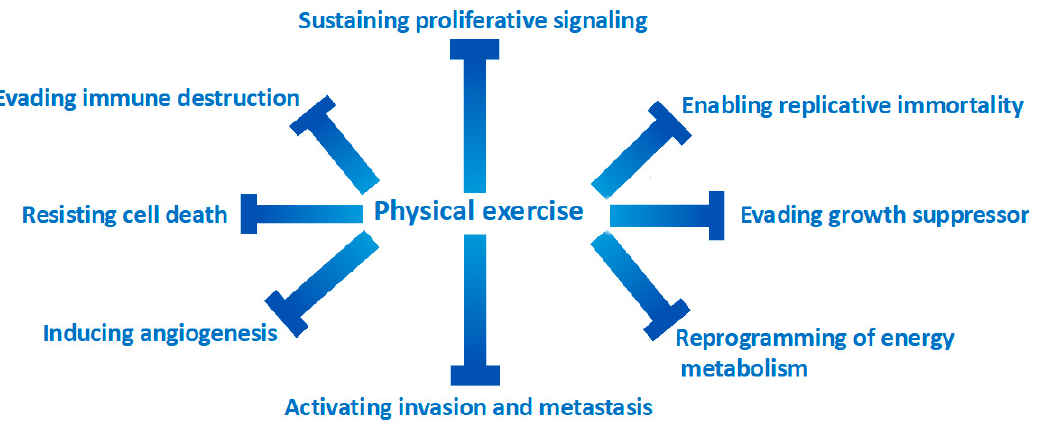
Figure 1. Exercise is effective in counteracting all the mechanisms of action responsible for the transformation of a normal cell into a cancer cell.